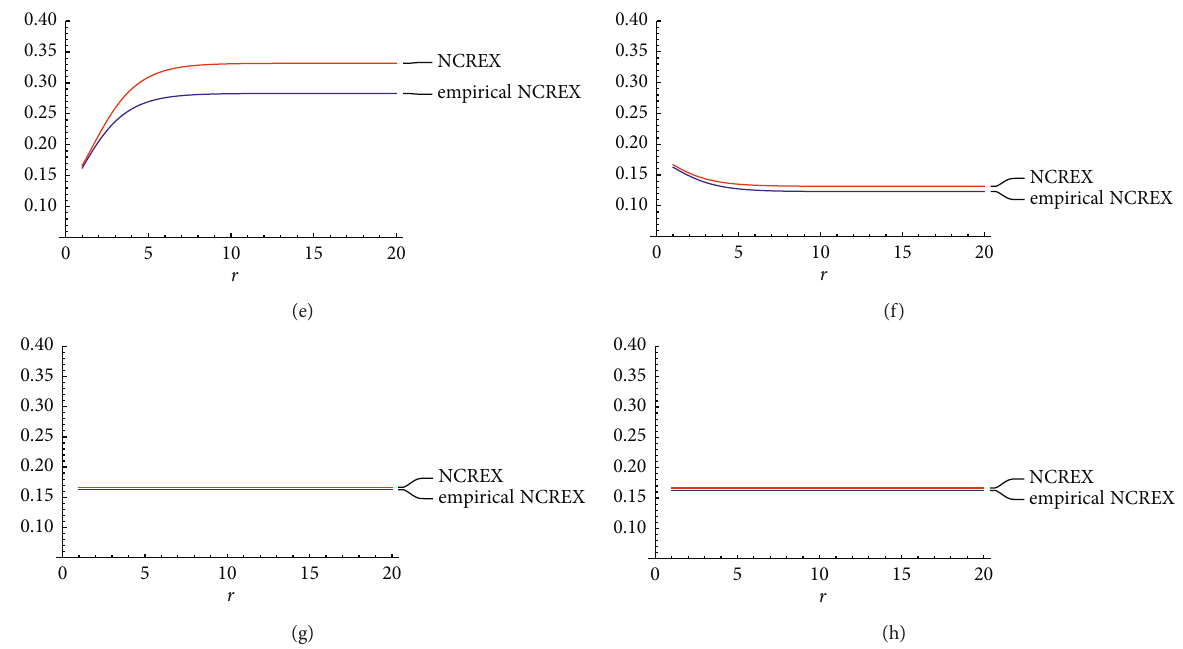
Figure 1: Representation of NCREX and empirical NCREX based on R 0.5. (d) p � 2, λ � − 0.25. (e) p � 3, λ � 0.3. (f) p � 3, λ � − 0.1. (g) p � 2, λ � 0 and (h) p � 3, λ �